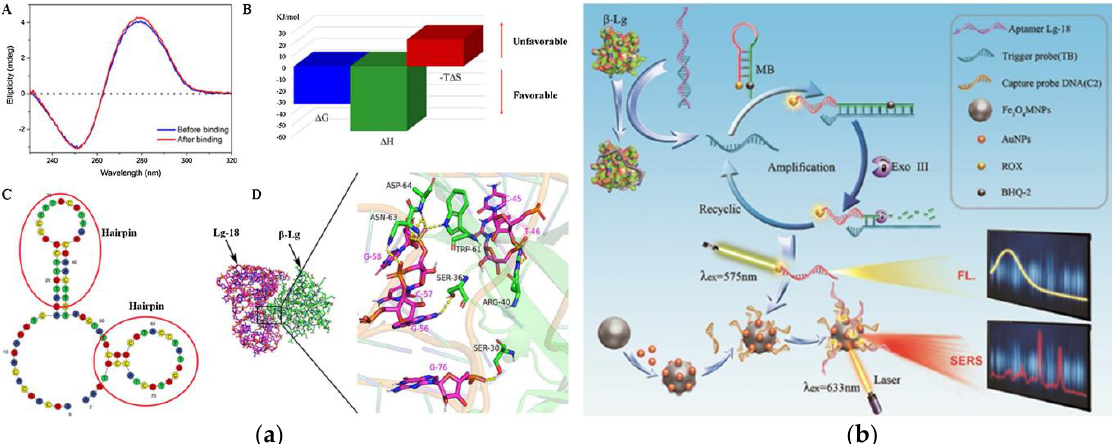
Figure 4. ( a ) Schematic of Lg-18 and β -lactoglobulin binding. A: Circular dichroism analysis of Lg-18 before and after binding. B: Analysis of thermodynamic parameters in the combined process. C: Secondary structure of Lg-18 predicted by Mfold online software. D: Analysis of molecular docking results of aptamer Lg-18 and β -lactoglobulin ( b ) Schematic of aptamer-based fluorescent Raman dual-mode biosensor for detection of β -lactoglobulin. Reproduced with permission from [166]. Copyright Sensors and Actuators B-Chemical, 2021.